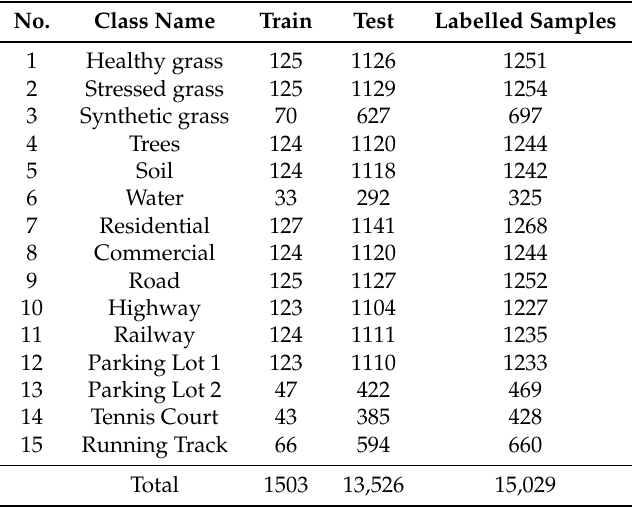
Table 9. Reference classes for the GRSS2013 data set.